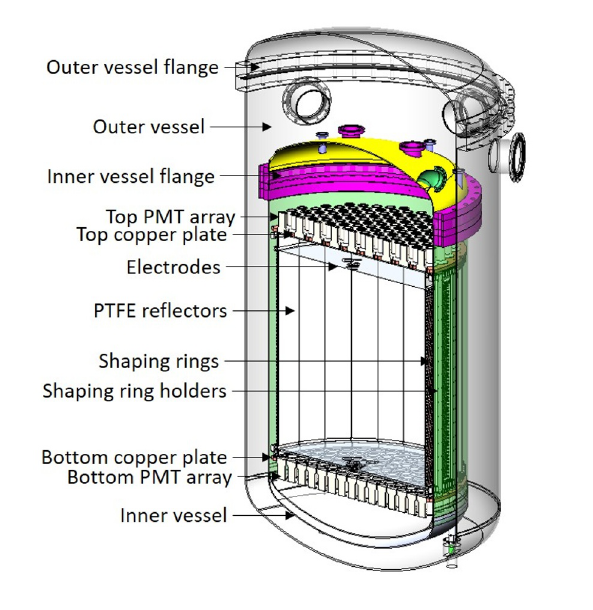
Figure 1. Layout of the PandaX-4T